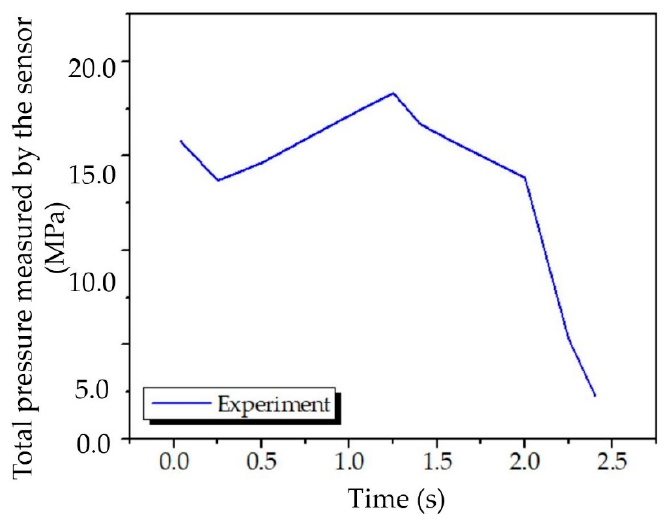
Figure 6. The total pressure measured by a sensor in the experiment.